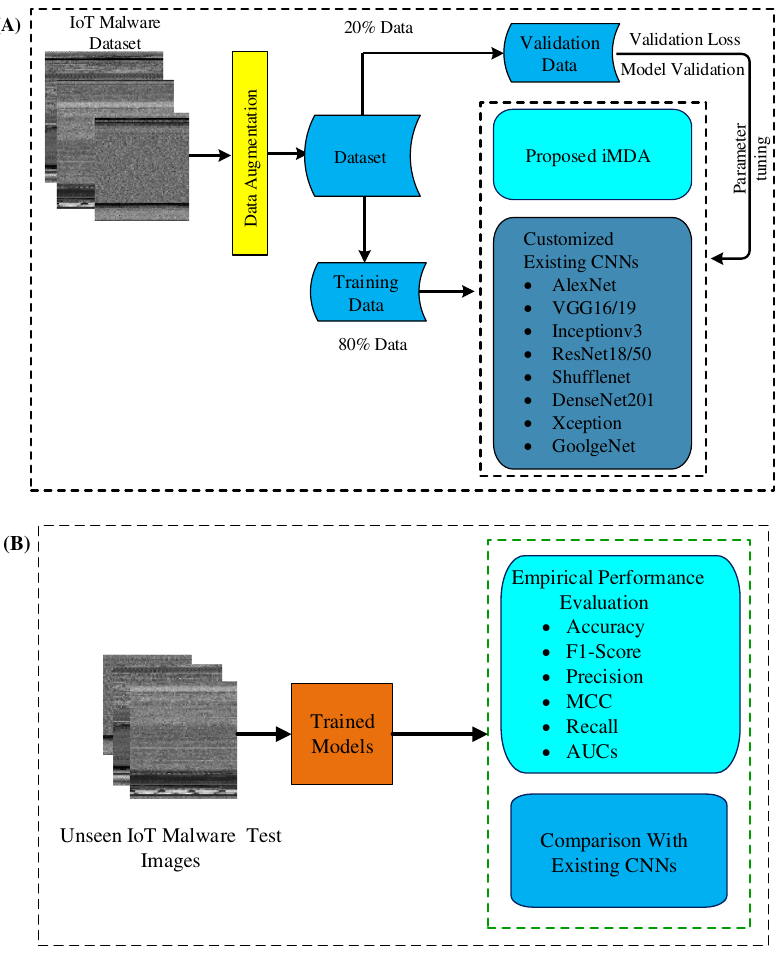
Figure 3. Detailed overview of training ( a ) and testing ( b ) of the proposed